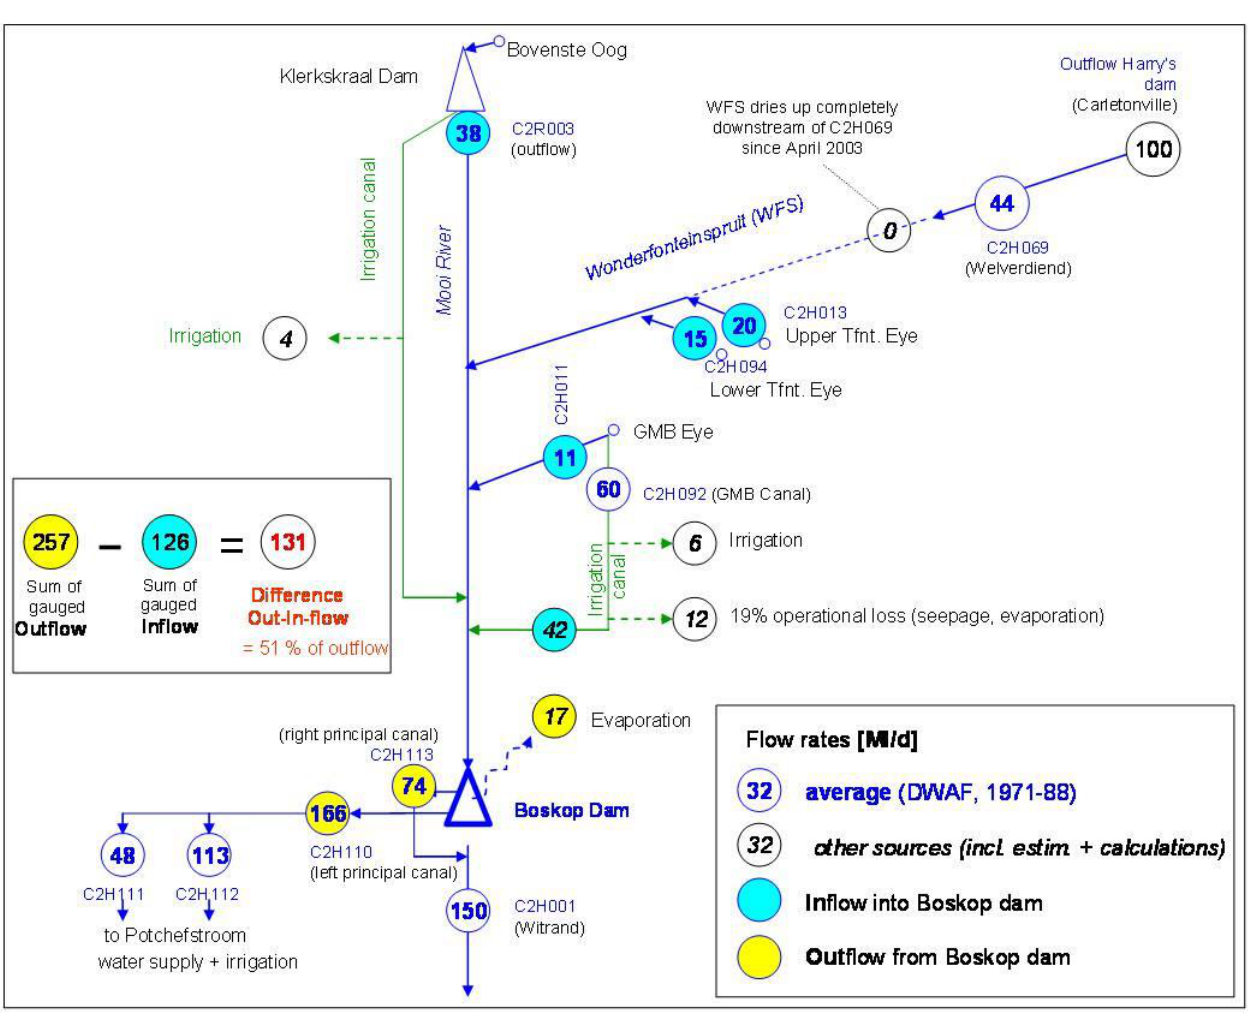
Figure 1. Tentative water balance for the Boskop Dam based on existing gauging data from the Department for Water Affairs